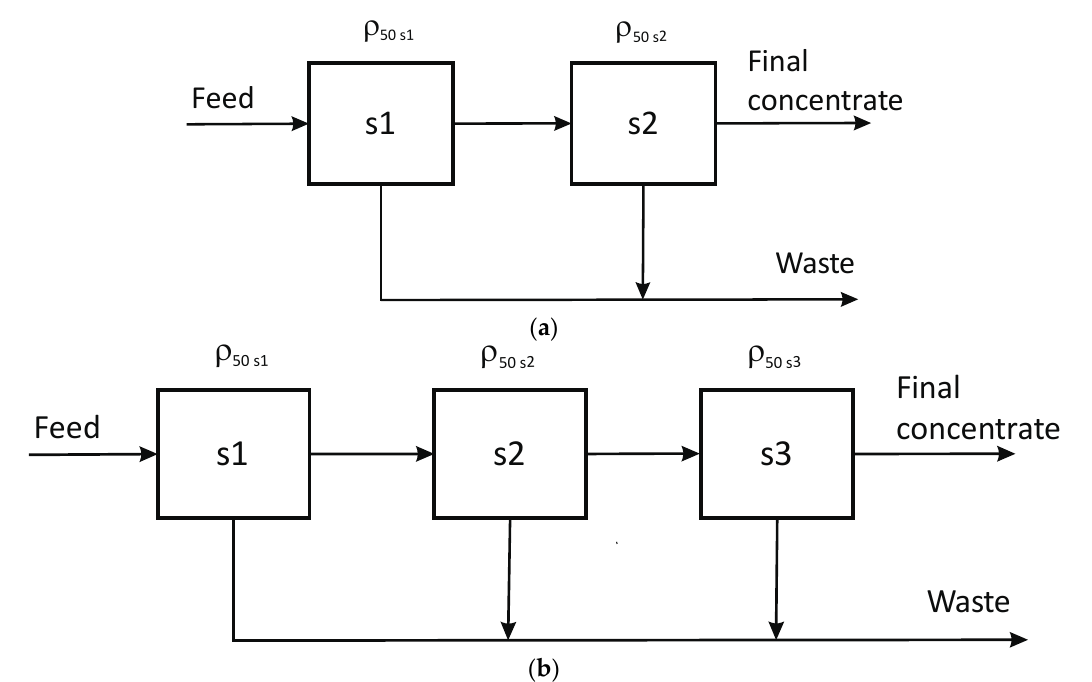
Figure 4. Systems of two and three separators with secondary enrichment of intermediate concen ‐ trates: ( a ) 2sep, ( b ) 3sep. trates: ( a ) 2sep, ( b )